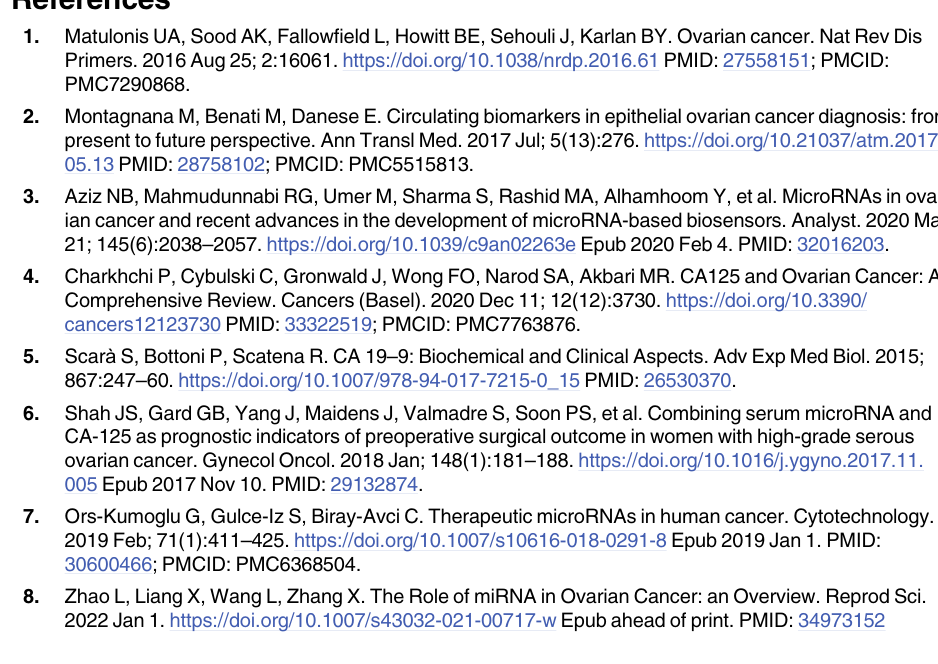
S4 Table. Pairwise comparisons of CA125 (U/ml) across all groups. S5 Table. Pairwise comparisons of CA19.9 (U/ml) across all groups. S6 Table. Pairwise comparisons of hepcidin (pg/ml) across all groups. S7 Table. Pairwise comparisons of MAGP2 (pg/ml) across all groups. S8 Table. Pairwise comparisons of ferroportin (pg/ml) across all